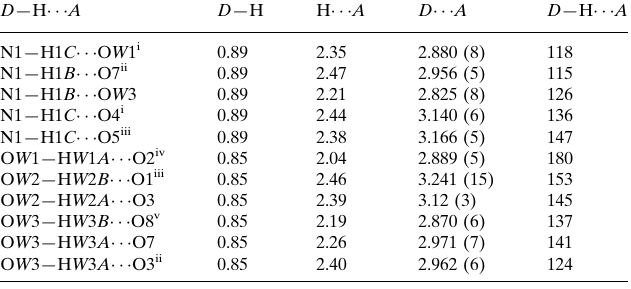
Hydrogen-bond geometry (A˚ , (cid:4)